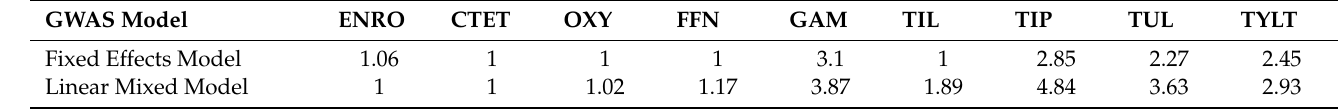
Table 2. Genomic inflation factors ( λ ) for each GWAS, where λ is the ratio of the median of the empirically observed distribution of the test statistic to the expected